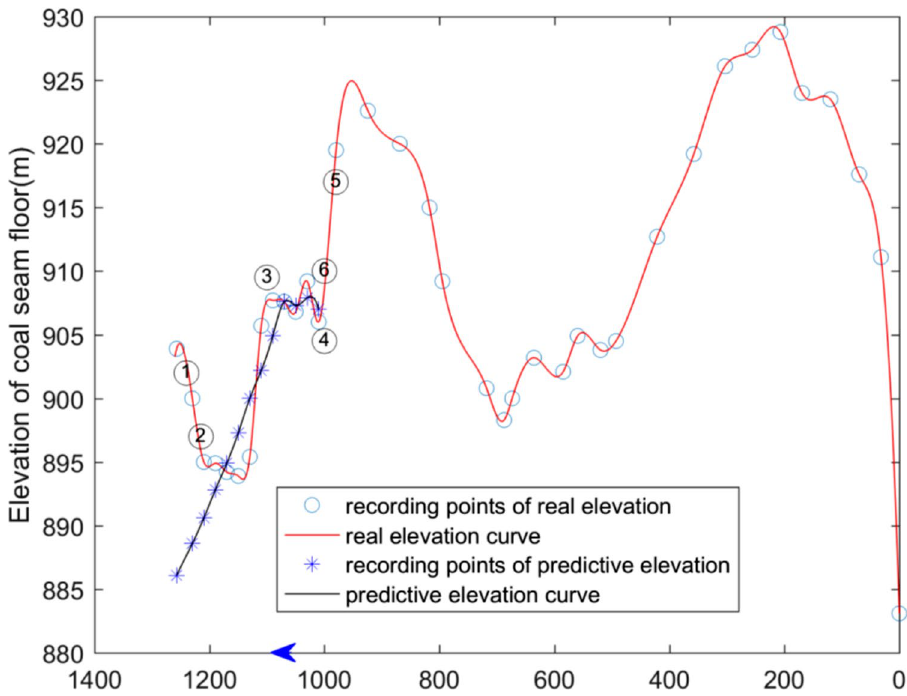
Figure 8. Curve of coal seam floor of haulage roadway (The blue * represents the elevation point calculated by surface spline function. The blue ◦ represents the real elevation point exposed by drivage. The arrow represents the direction of laneway excavation. The symbol ① ~ ⑥ are interpreted in the Table 3).